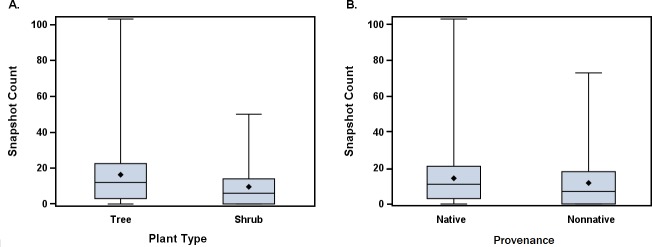
Comparison of snapshot counts on trees and shrubs, and native and non–native plants.The bold line within the box indicates the median while the diamond indicates the mean. The lower whisker, lower box, upper box, and upper whisker indicate first, second, third, and fourth quartiles, respectively. Whiskers also show minimum and maximum values (range). Analysis of variance results are summarized in Table 4.